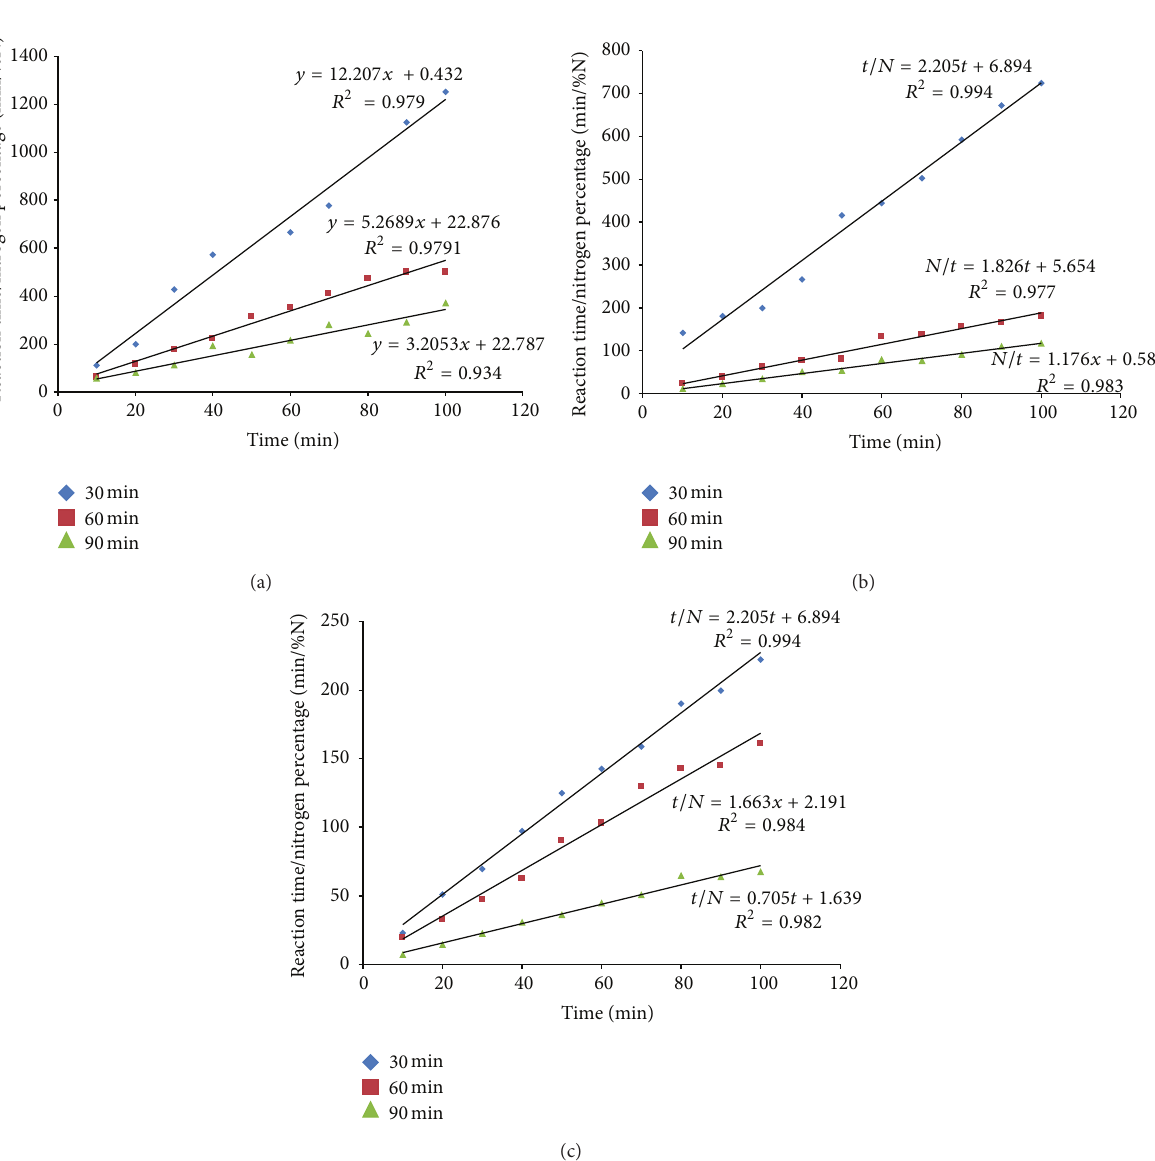
Figure 3: Linearized representation of the pseudo-second-order rate equation for cationized cellulose, previously alkalized with (a) NaOH 10%, (b) NaOH 20%, and (c) NaOH